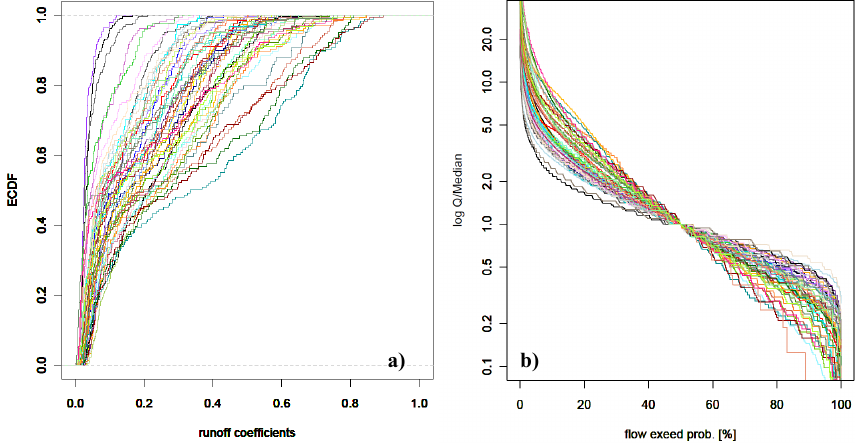
Fig. 3. Catchments response behaviour of 53 catchments for the entire year: (a) empirical cumulative distribution functions of event runoff coefficients and (b) flow duration curves, normalized by median.